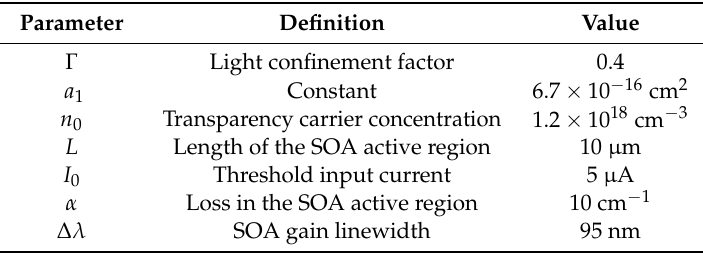
Table 1. Definitions and values of SOA